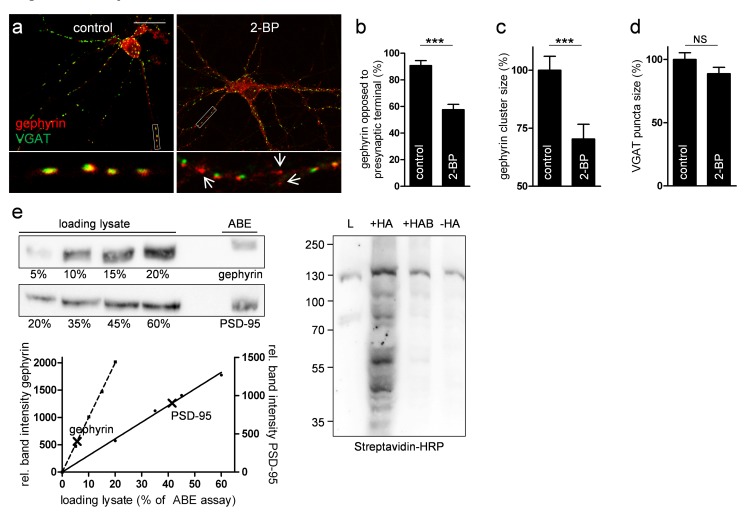
Palmitoylation of gephyrin is essential for clustering at GABAergic synapses.(a) Immunostaining of gephyrin (red) and VGAT (green) in primary hippocampal neurons. Insets are taken from 20 µm dendritic segments. Arrows point to nonsynaptic gephyrin clusters upon incubation with 2-BP. Scale bar, 20 µm. (b–d) Histograms showing quantitative comparisons of (b) gephyrin colocalization with VGAT, (c) gephyrin cluster size, and (d) VGAT puncta area in control and 2-BP–incubated cultures. (e) Quantification of percentage of palmitoylated proteins in mouse brains. Immunoblots with increasing volumes of ABE-assay–processed protein lysates were used to create a band-intensity standard curve for ABE-assay eluates of gephyrin and PSD-95. The experiment has been performed with three brains. (f′) Streptavidin-HRP immunoblot served as a specificity and accuracy control of the assay. L, lysate; +HA, samples processed with hydroxylamine; +HAB, +HA supernatant after Neutravidin beads sedimentation to prove efficient affinity-purification of biotinoylated proteins; −HA, internal control of the ABE assay without hydroxylamine.